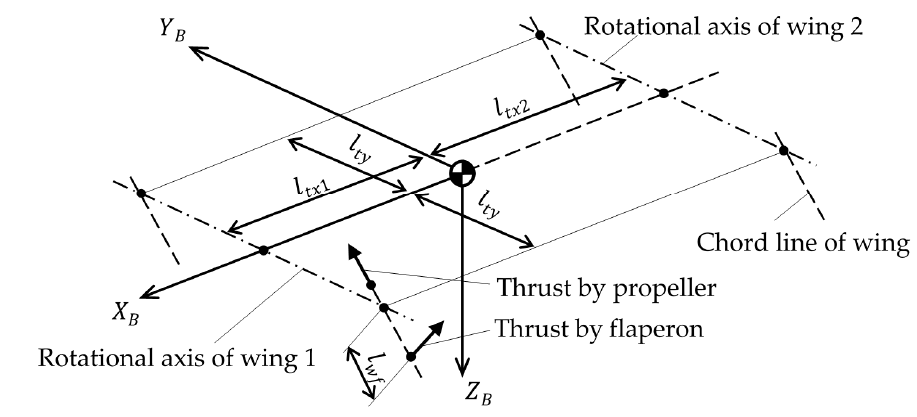
Figure 3. Arrangement of the propeller and flaperon.